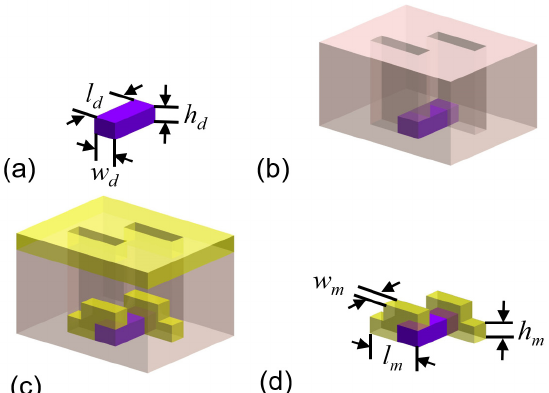
Figure 1. The schematic of the fabrication steps for the plasmonic molecule with stereo-structure. ( a ) The dielectric strip with the geometrical parameters of w d , l d and h d . ( b ) the resist layer with two rectangular holes is the template for the following step. ( c ) metallic film deposition. ( d ) the final plasmonic stereo-molecule after removing the resisted layer. The geometrical parameters of the metallic strip are w m , l m and h m .